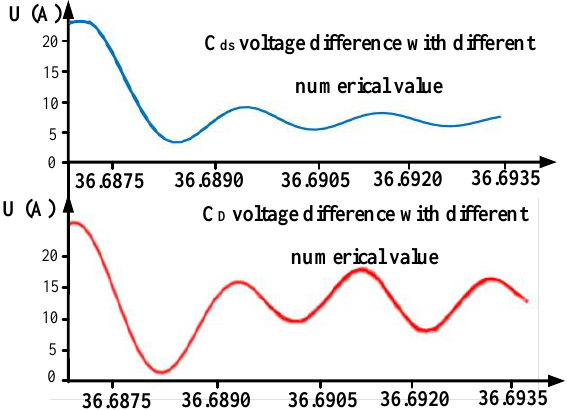
ff erent parasitic parameter